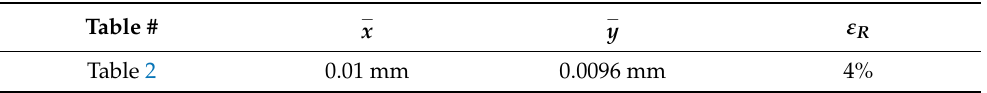
Table 3. Summary of the statistical analysis of | D c | based on the eccentricity of the crankshaft (e c ).